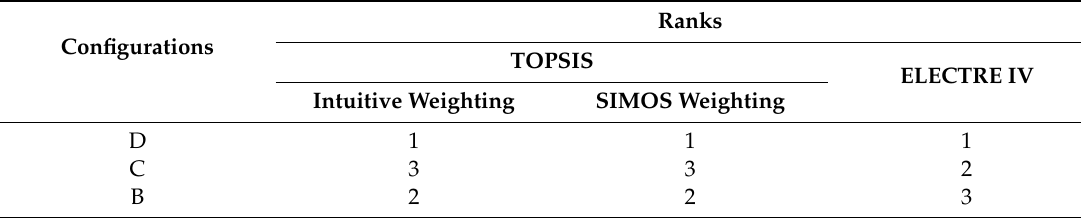
Table 16. Summarized results of the suggested